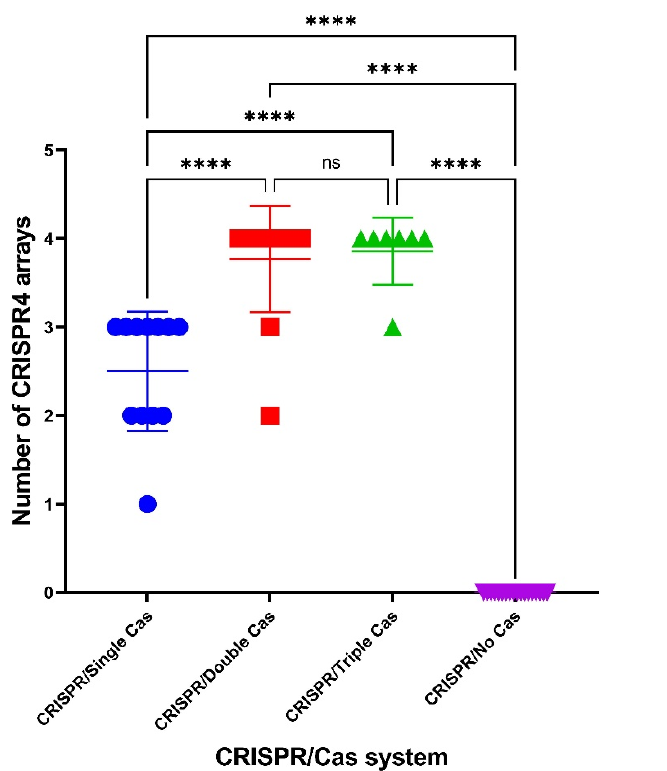
Figure 6. Comparison of CriePir P. aeruginosa isolates having different CRISPR/Cas systems by the number of CRISPR4 arrays. **** indicates the level of significance p < 0.0001.